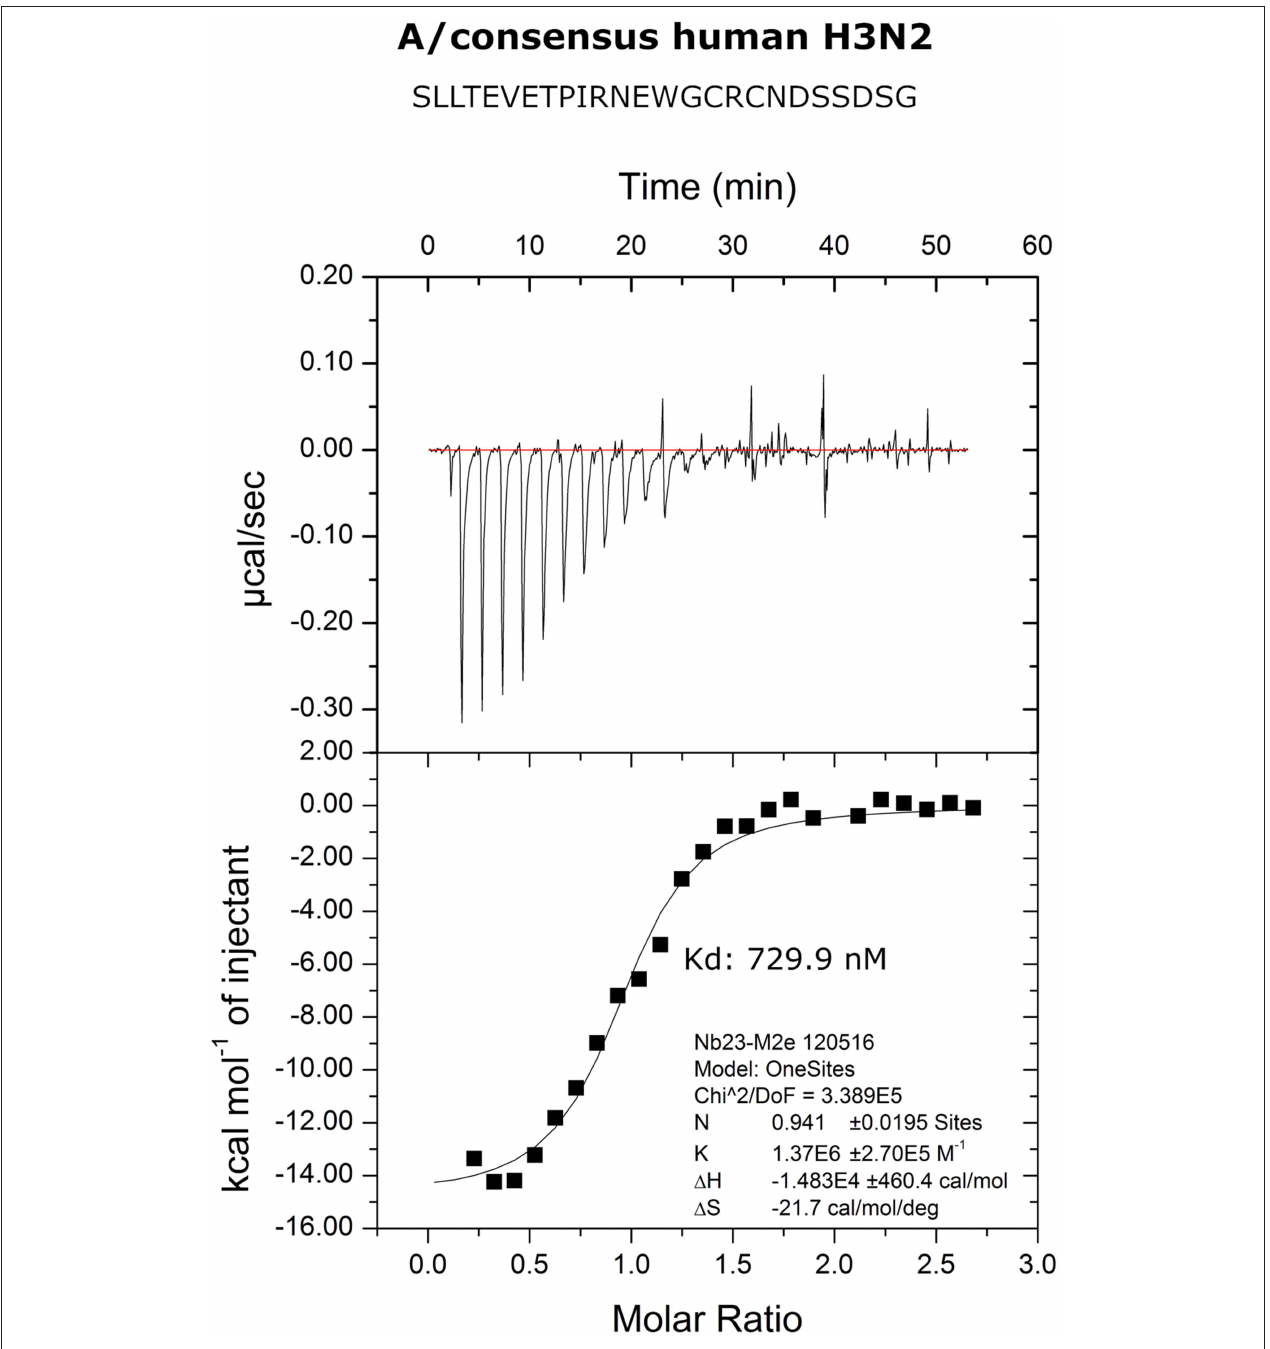
FIGURE 2 | Thermodynamic characterization of the M2e:M2e-VHH-23m interaction. Isothermal titration calorimetry of the Me peptide into M2e-VHH-23m.